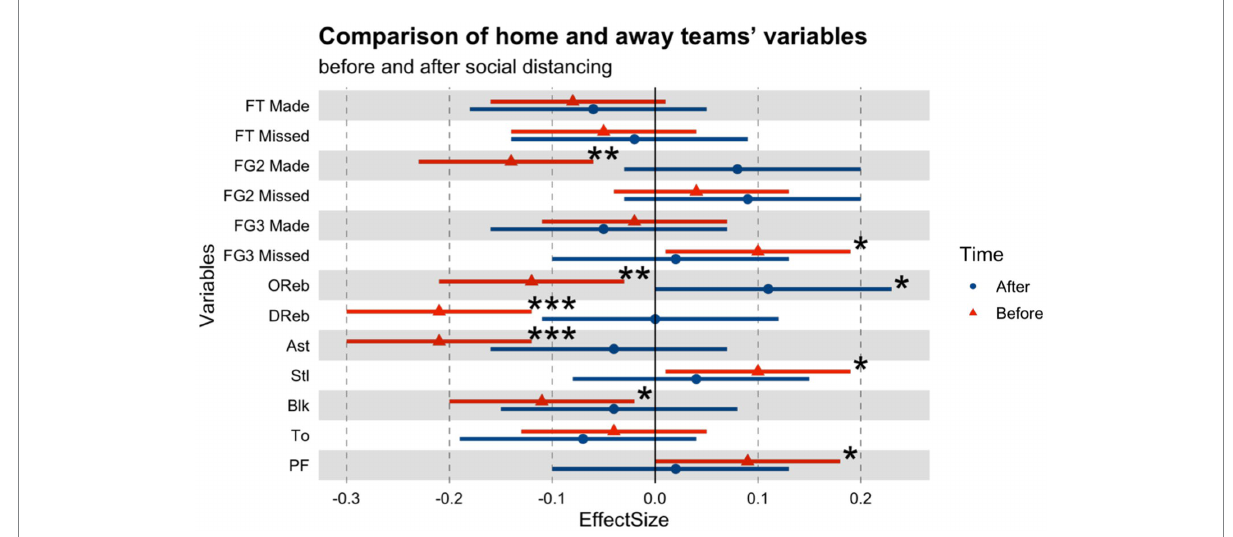
FIGURE 1 Comparison of home and away teams’ variables before and after social distancing. * p < 0.05, ** p < 0.01, *** p < 0.001. FT, free-throw; FG2, two field-goals; FG3, three field-goals; OReb, offensive rebounds; DReb, defensive rebounds; Ast, assists; Stl, steals; Blk, blocks; To, turnovers; PF, personal fouls.